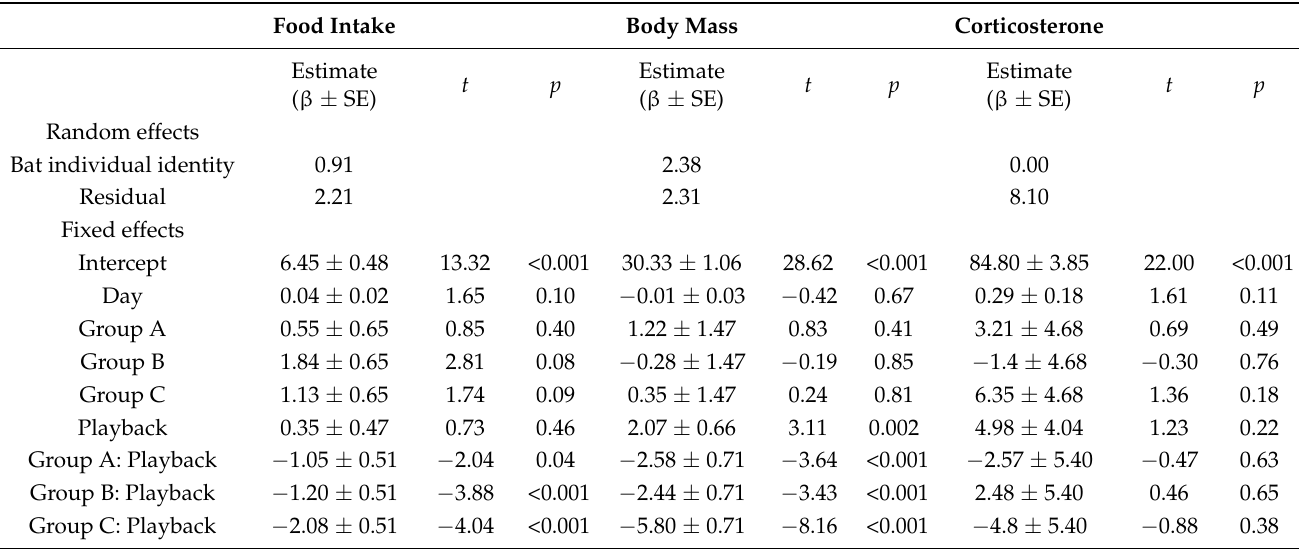
Table 1. Results of mixed-effect models on daily food intake, body mass, and fecal CORT hormone levels of bats in four